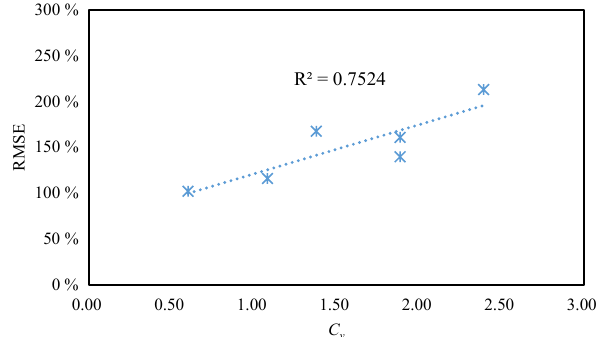
Figure 9. The relationship between RMSE and C v in the temporal